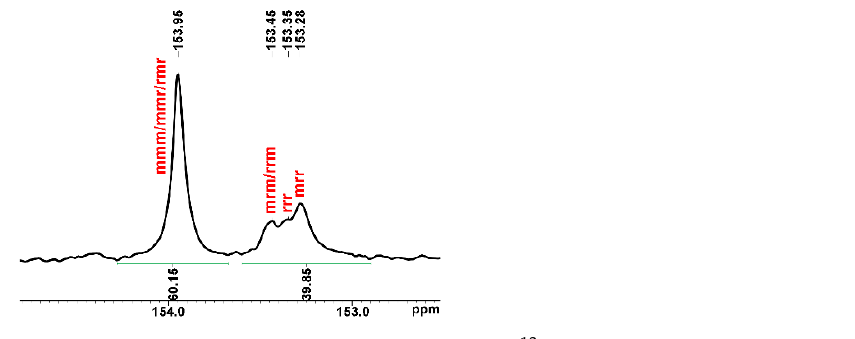
Figure 4. Magnification of carbonyl signals in the 13 C NMR spectrum (151 MHz, C 6 D 6 , 25 °C) of PCHC (entry 5 , Table 2; full spectrum in Figure S17).